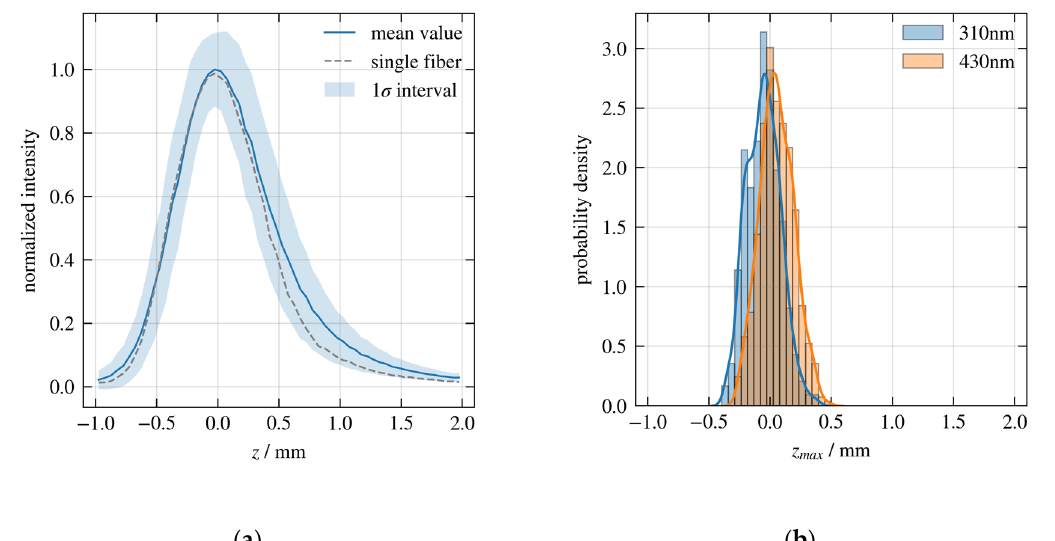
Figure 9. ( a ) Average intensity profile obtained by scanning a premixed flat laminar flame vertically through the measurement plane. The z -axis is normal to both, the flat flame and the tomographic plane and the flame front is at z = 0 mm. ( b ) Distributions of the position of the maximum intensity of each individual optical fiber, separated by wavelength.